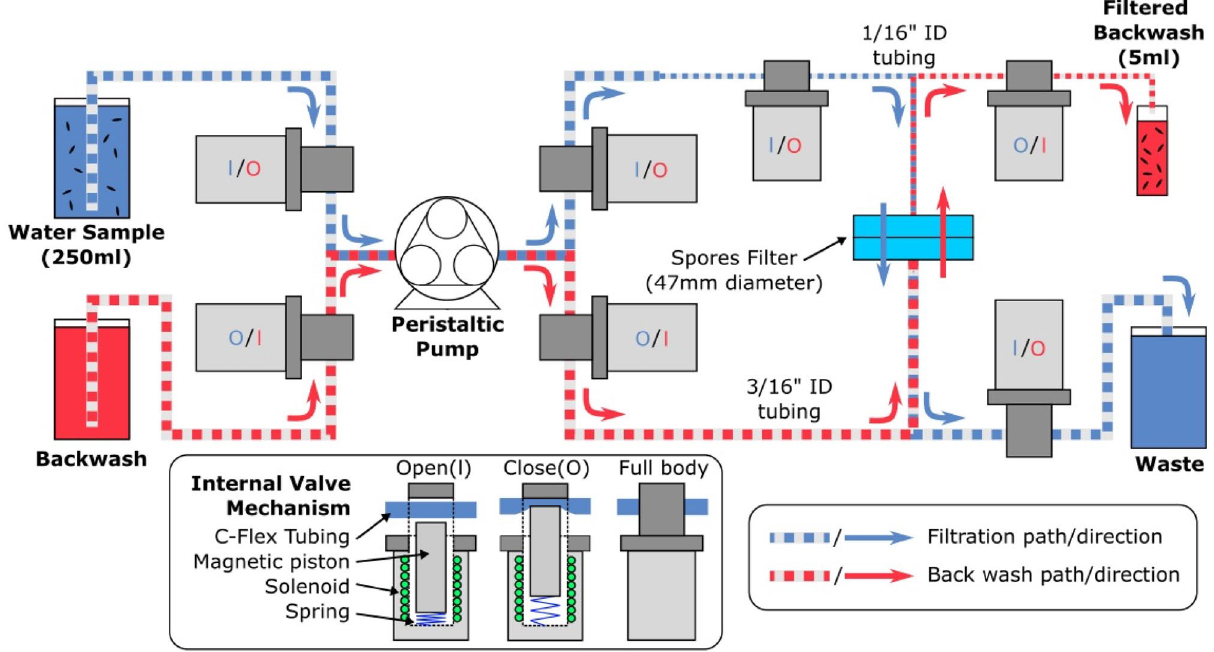
Figure 1. Schematic diagram of the water sampling module (WSM-S) used to filter and concentrate spores into a 5 mL backwash solution from a 250 mL water reservoir. The filtration (blue arrows) and backwash (red arrows) runs are indicated by respective flow directions controlled by the peristaltic pump and a set of electromagnetic pinch